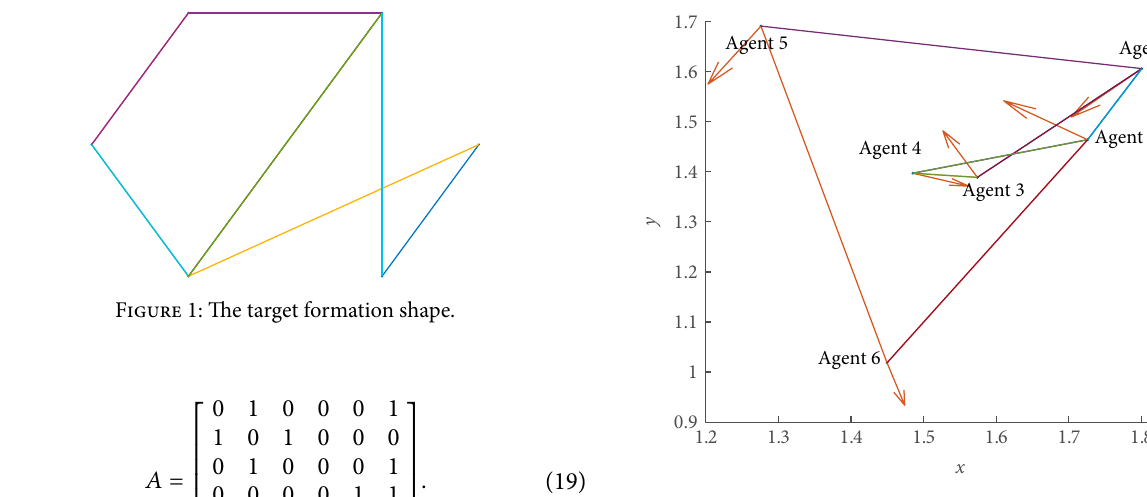
Figure 2: The initial positions and velocities of a six-agent.